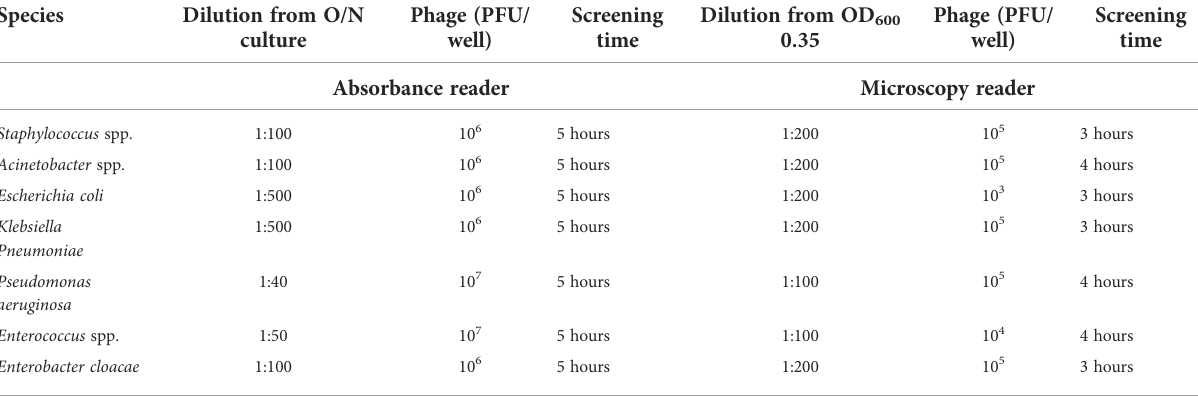
TABLE 4 Species-speci fi c optimizations for phage susceptibility testing*. Species Dilution from O/N